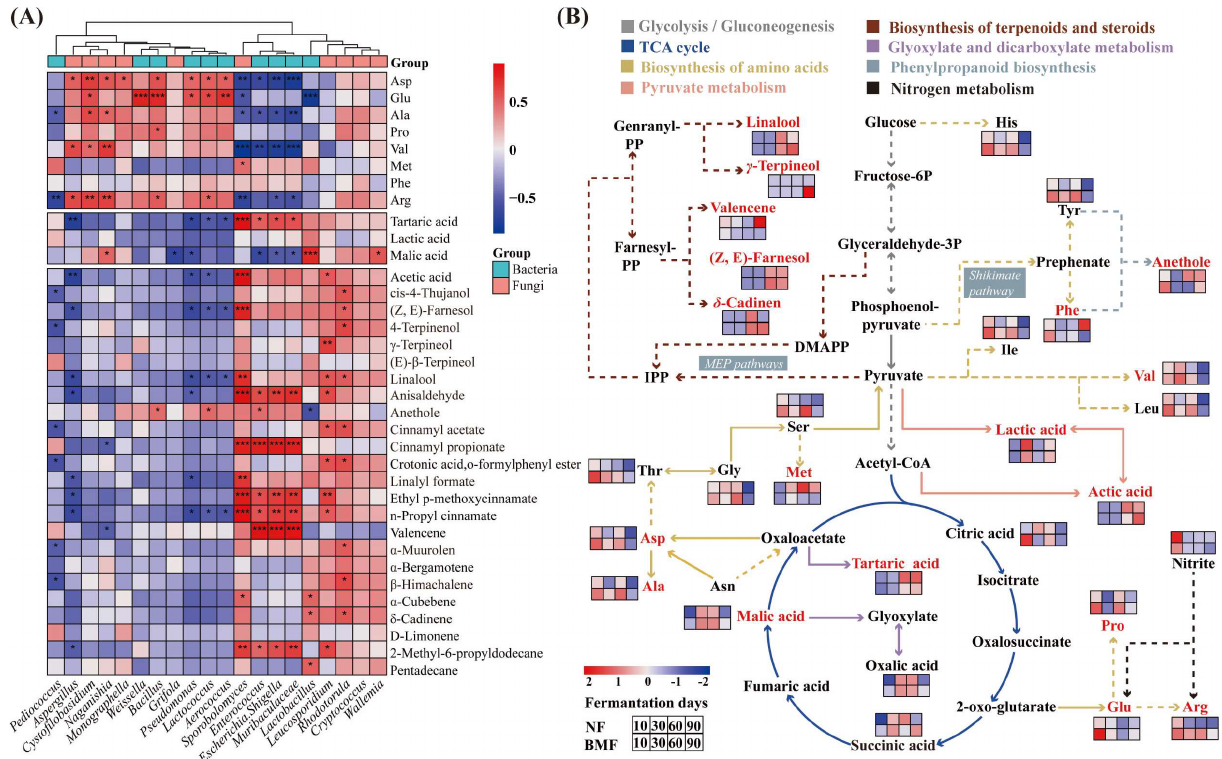
Figure 6. ( A ) The correlation of differential metabolites and differential microbes. ( B ) Metabolic pathway map of microbes according to KEGG and heatmap reflecting the changes of some major metabolites. The solid lines indicate direct synthesis, while the dotted lines indicate indirect synthesis. *: p < 0.1, **: p < 0.01, ***: p < 0.001. Lactic acid, one of the essential OAs in fermented vegetables, not only provides a unique flavor, but also increases the acidity of fermented vegetables [9]. Pyruvate is an important precursor of OAs, which can be converted into lactic acid and other OAs under the catalysis of pyruvate dehydrogenase, pyruvate oxidase, and acetokinase [27]. Moreo- ver, Lactobacillus was reported as a main producer of enzymes associated with pyruvate conversion [8], which showed a positive correlation with lactic acid and malic acid in this study (Figure 6A). Compared to NF, BMF presented a higher relative abundance of Lacto- bacillus during fermentation (Figure 4B), seen in the fact that the dominant role of Lactoba- cillus in the synthesis of OAs had promoted after inoculation with B. marcorestinctum YC- 1, which was consistent with higher content of OAs in BMF (Figure 2A and Table S3). Nitrite can be converted into ammonia when catalyzed by nitrate reductase and ni- trite reductase (Figure 6B), and ammonia can be consumed by Lactobacillus as a nitrogen source to produce Glu and Arg [16]. Furthermore, malic acid and tartaric acid have been